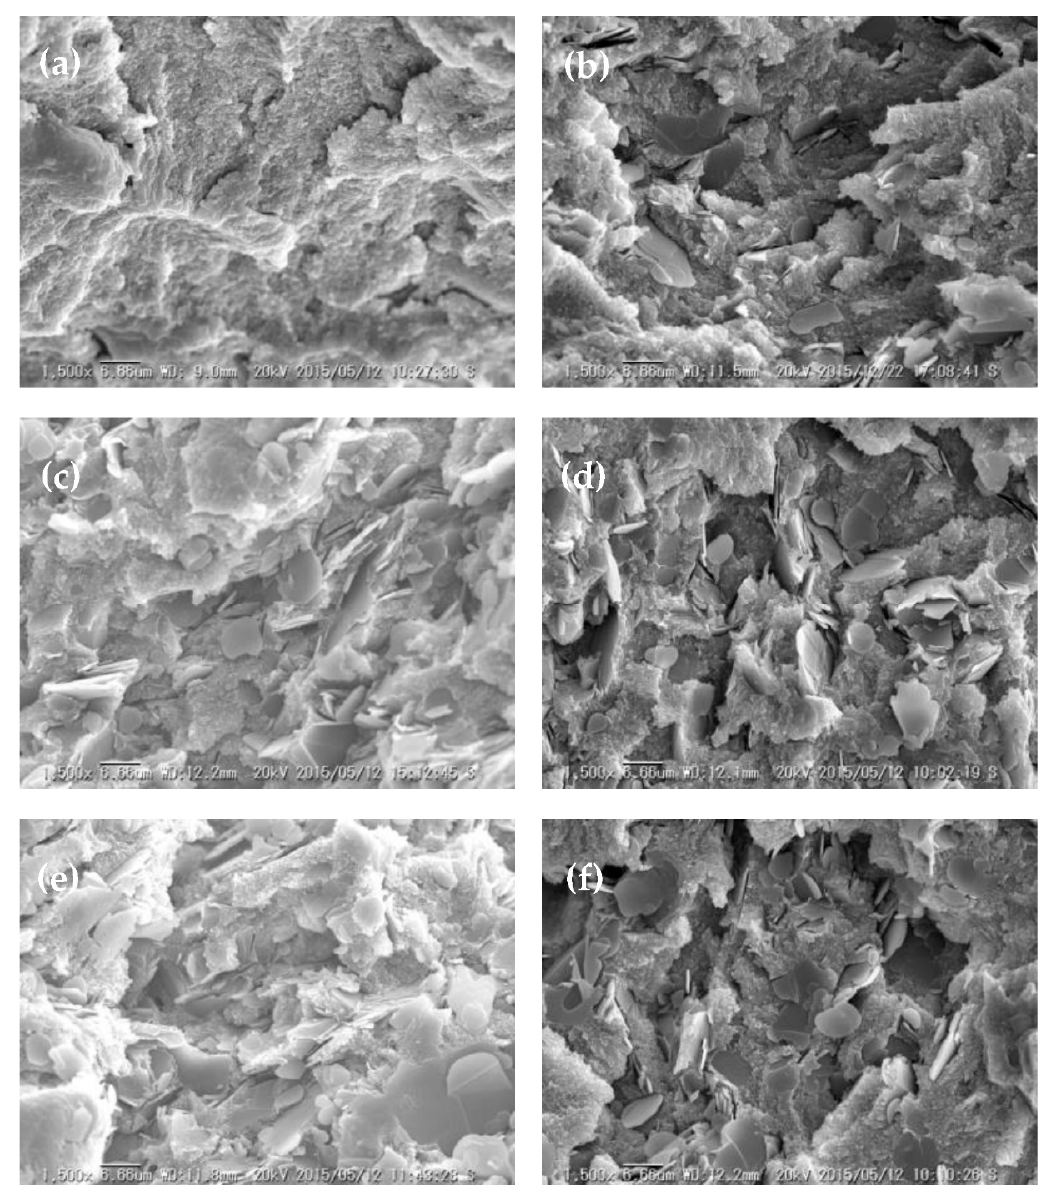
Figure 2. SEM images of ( a ) PTFE, ( b ) PTFE-BN-3, ( c ) PTFE-BN-5, ( d ) PTFE-BN-7, ( e ) PTFE-BN-9, and ( f ) PTFE-BN-11.